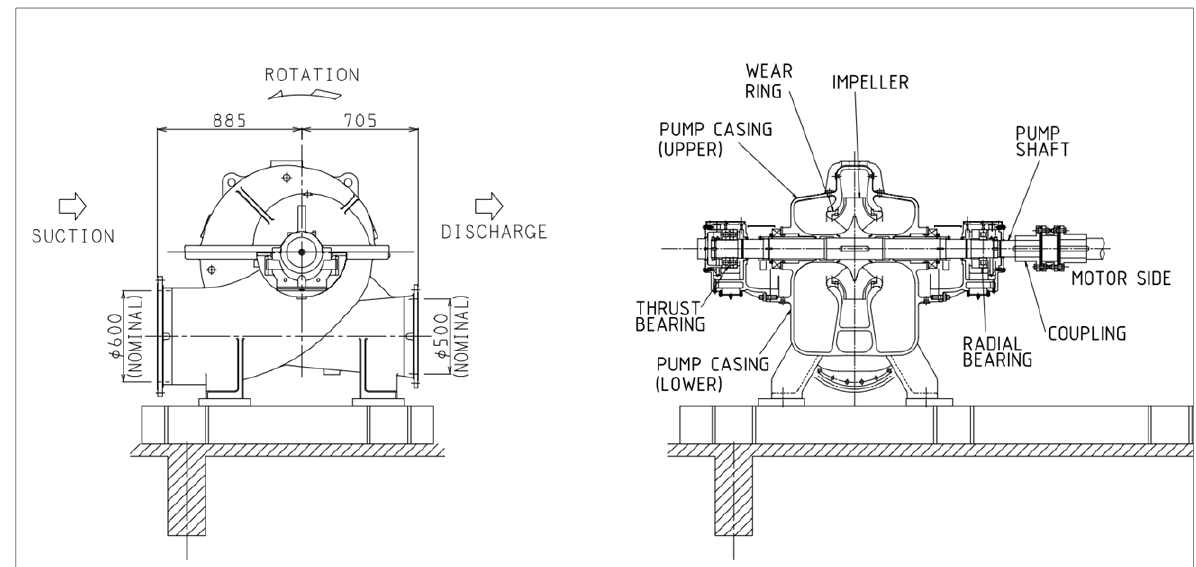
Figure 1. General arrangement drawing of a double-volute double-suction centrifugal pump.